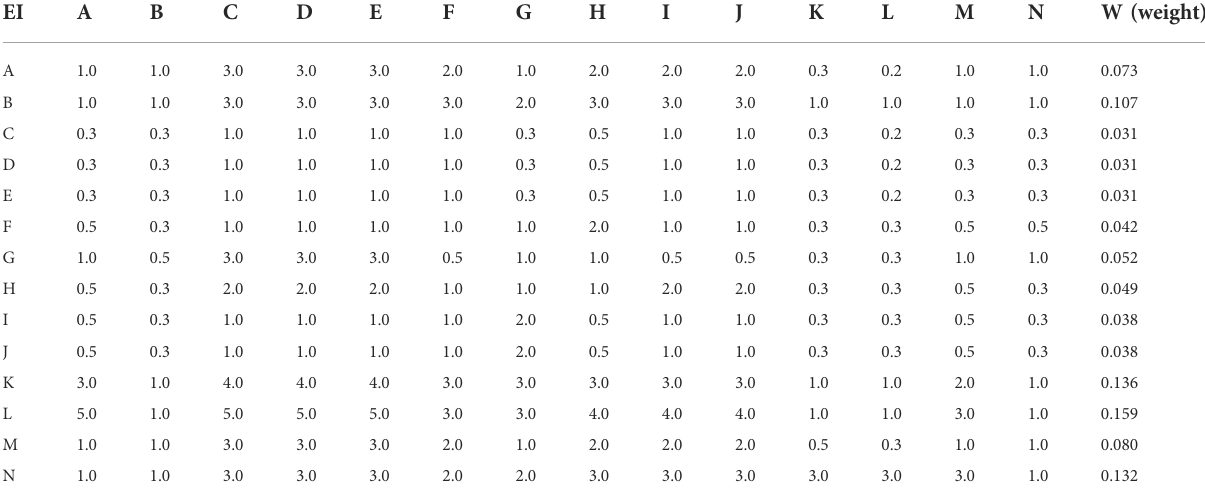
TABLE 2 AHP judgement matrix for the 14 in fl uencing factors.